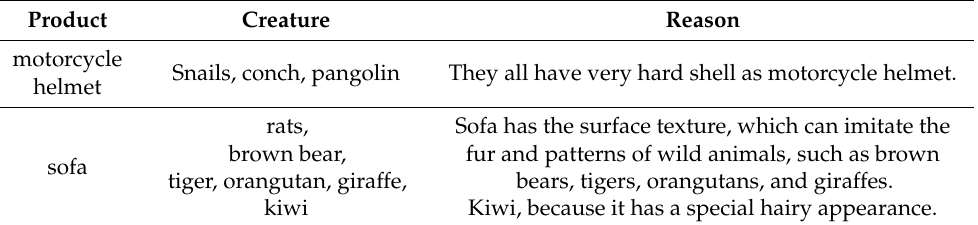
Table 5. Product material- creature material reasoning (19